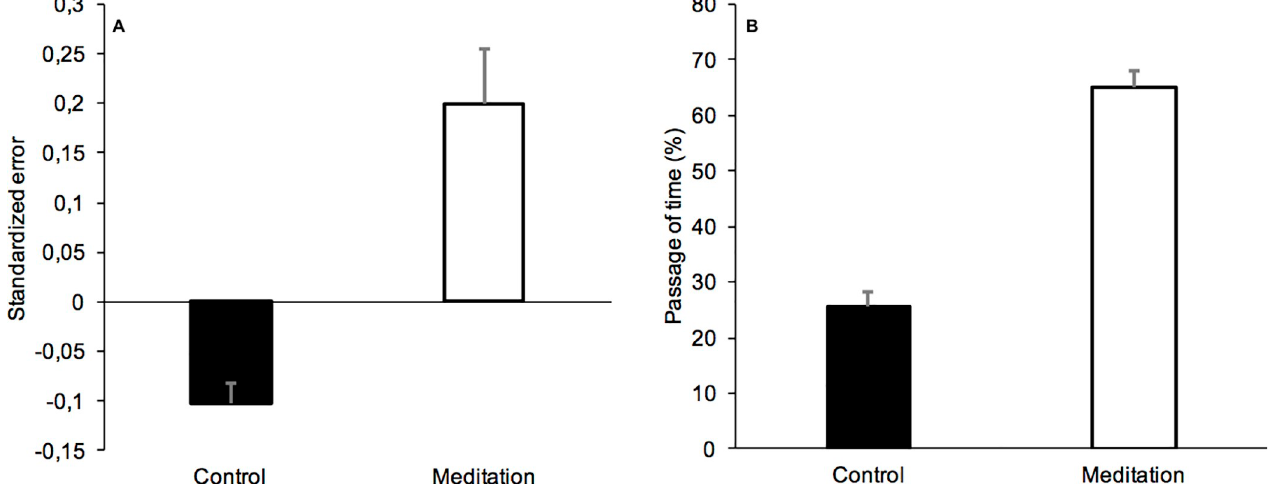
Fig 3. Time estimates and passage of time judgment. (A) Mean ( SE ) temporal standardized error and (B) mean ( SE ) passage of time judgment in the meditation and the control group for the minute duration